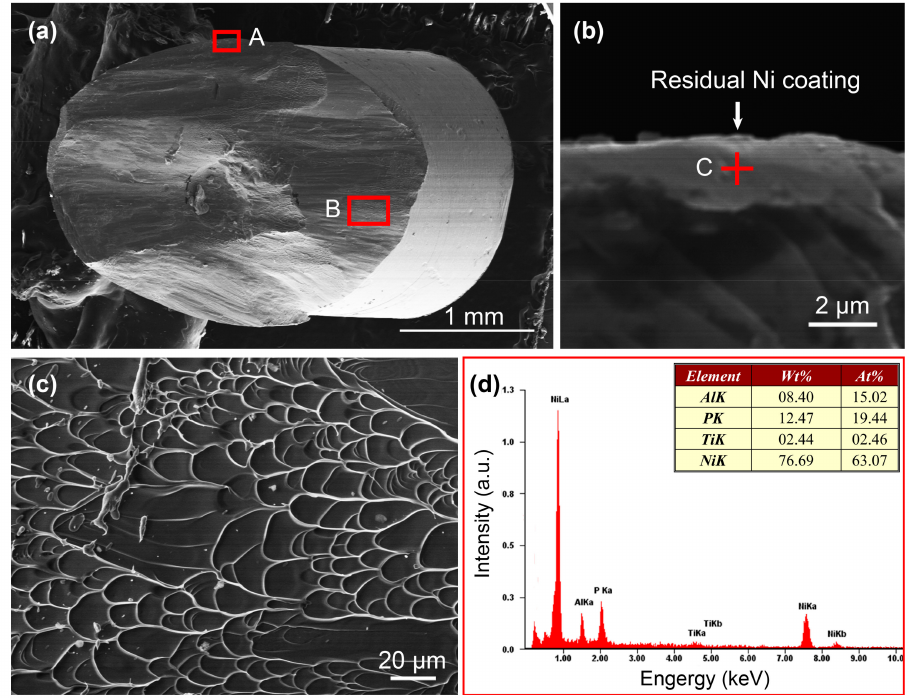
Figure 7. ( a ) The overall SEM images of the fracture surface of typical Ni-coated BMG sample after fracture; ( b ) High magnification image of the red square marked by A in ( a ); ( c ) Vein like pattern in region B of ( a ); and, ( d ) EDS spectrum of cross C in ( b